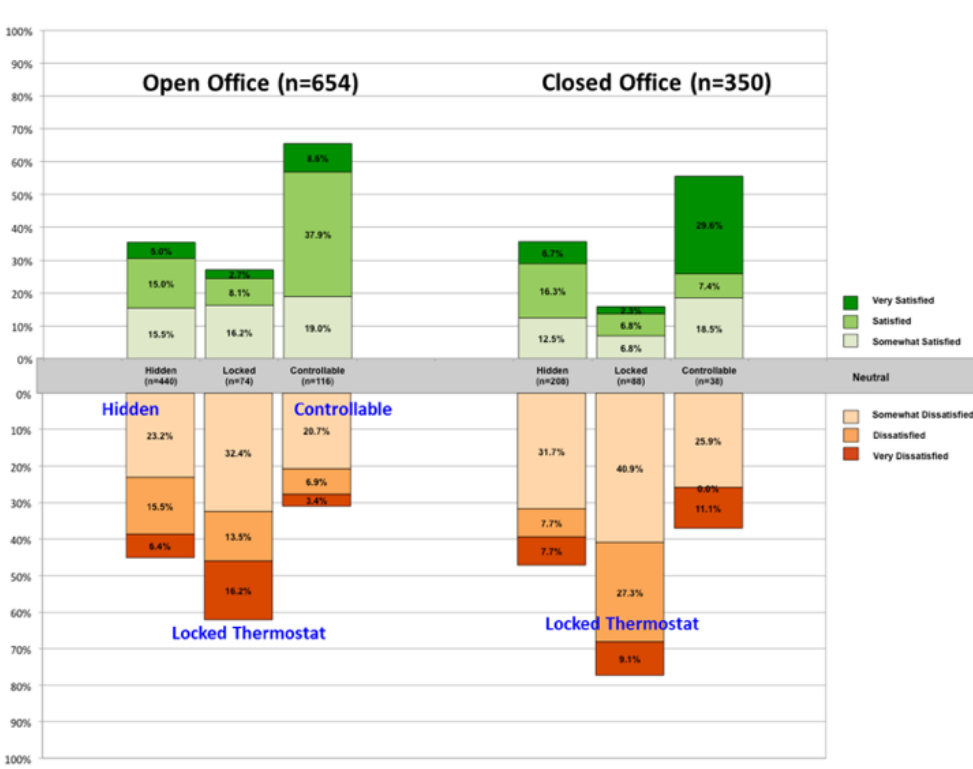
Figure 8. User satisfaction on air temperature by the level of control (Open and Closed Offices).